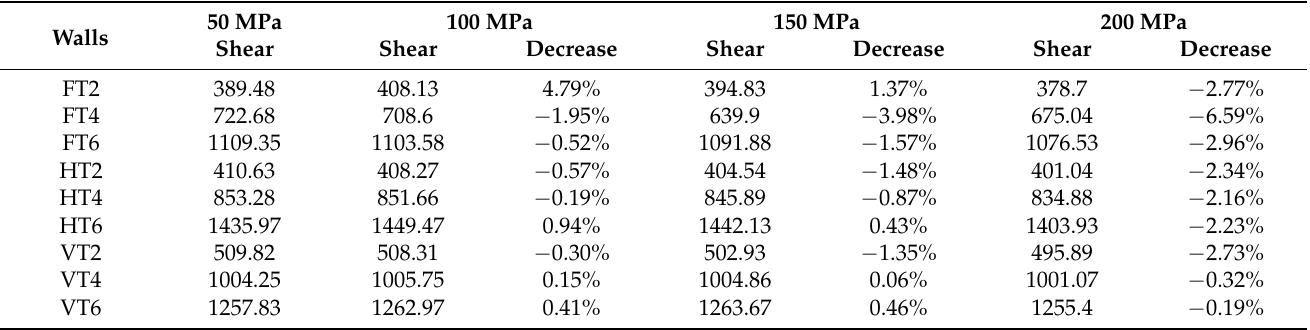
Table 5. Shear strength under different gravity